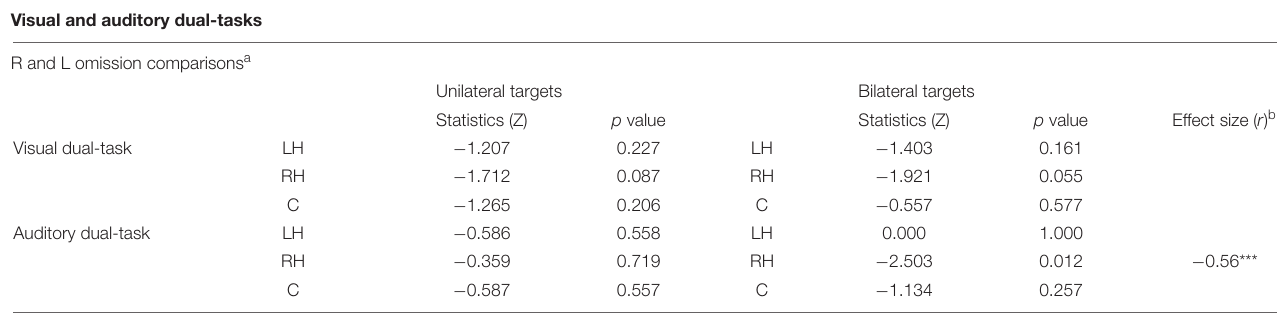
TABLE 6 | Comparisons between left-sided and right-sided omissions in Visual and Auditory dual-tasks within each group. Visual and auditory dual-tasks R and L omission comparisons a